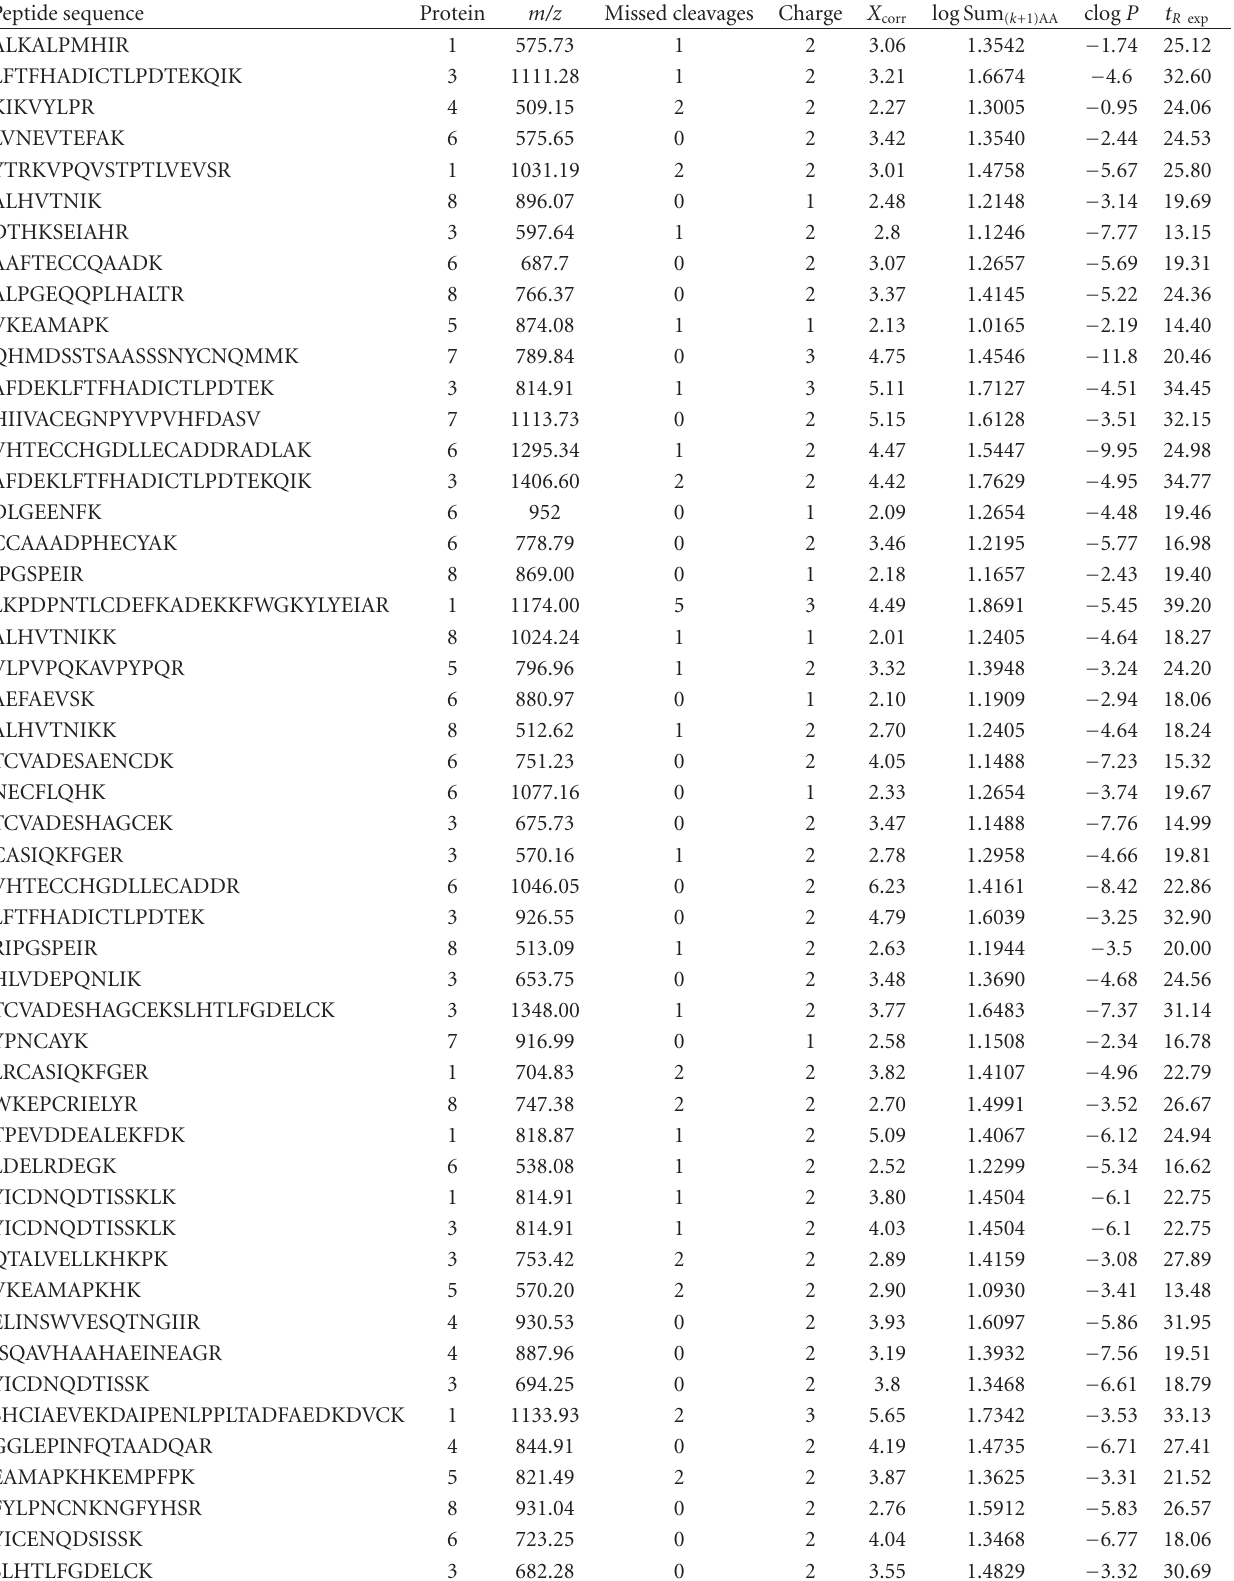
Table 1: Model peptides used to derive QSRR